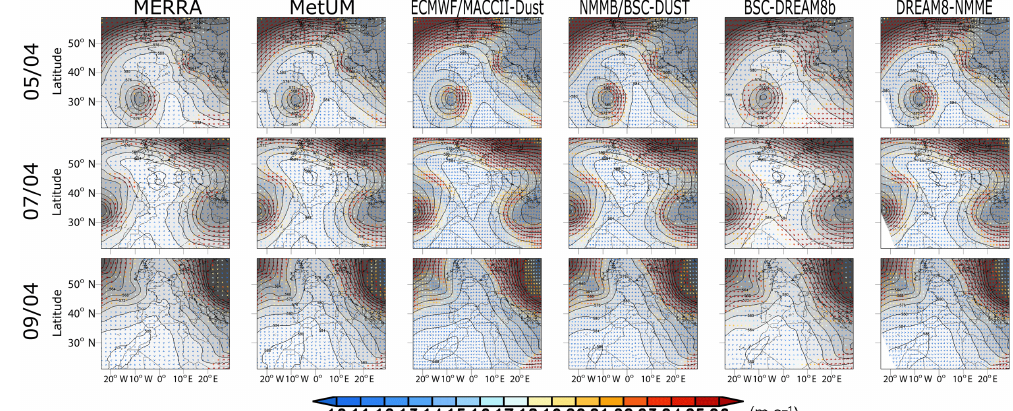
Figure 9. Same as Fig. 8 but for 500hPa.